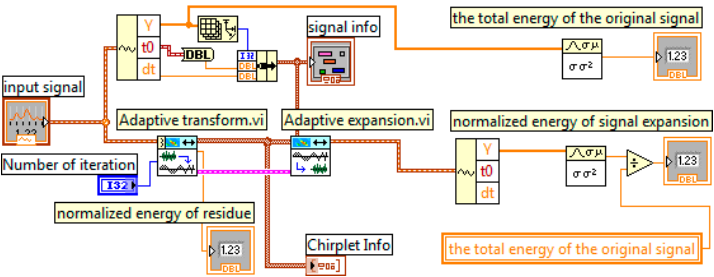
Figure 3. The part of the block diagram of the virtual analyzer that calculates the components of the signal energy and outputs the matrix of the chirplet parameters.